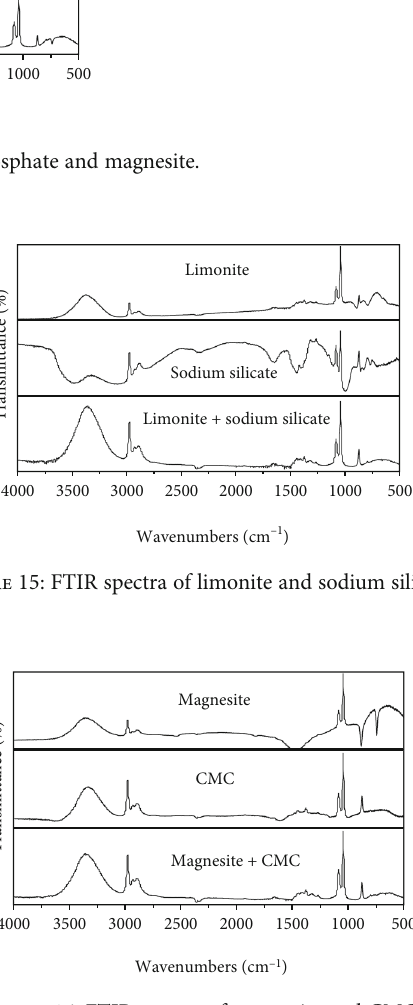
Figure 16: FTIR spectra of magnesite and